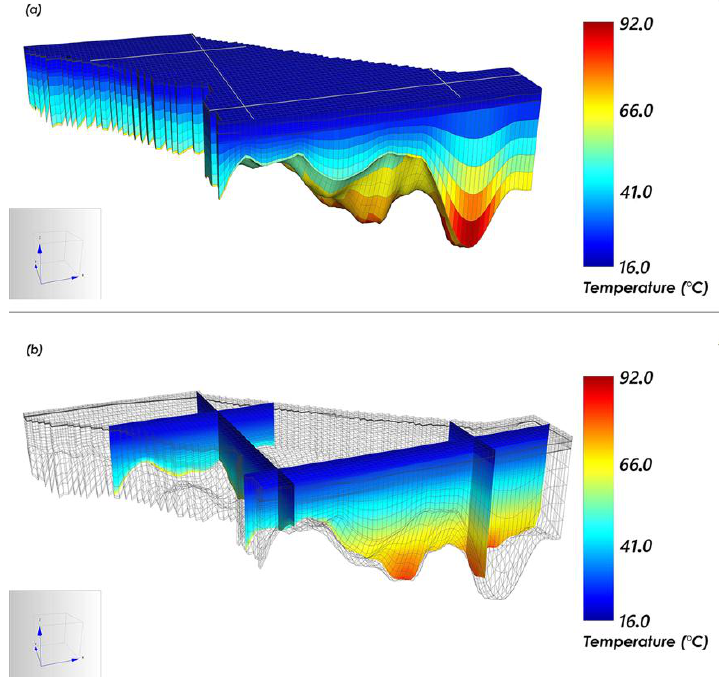
Figure 9. Temperature simulation results in the steady state: ( a ) Color block plot; ( b ) N–S and E–W cross-sections. Model volume is the same as in Figures 7 and